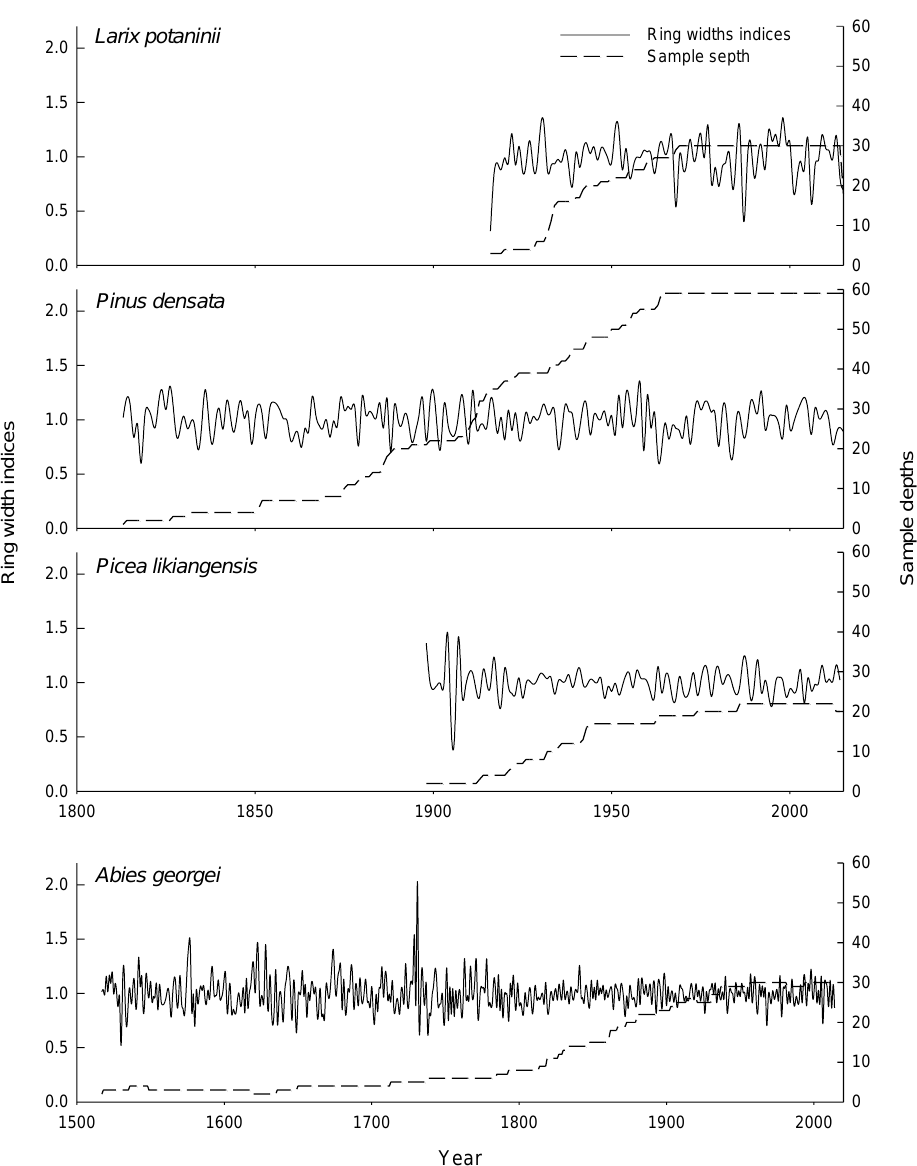
Figure 3. Residual tree-ring chronology (solid line) and sample size (dotted line). Table 2. Statistics of residual chronologies and common interval analysis.